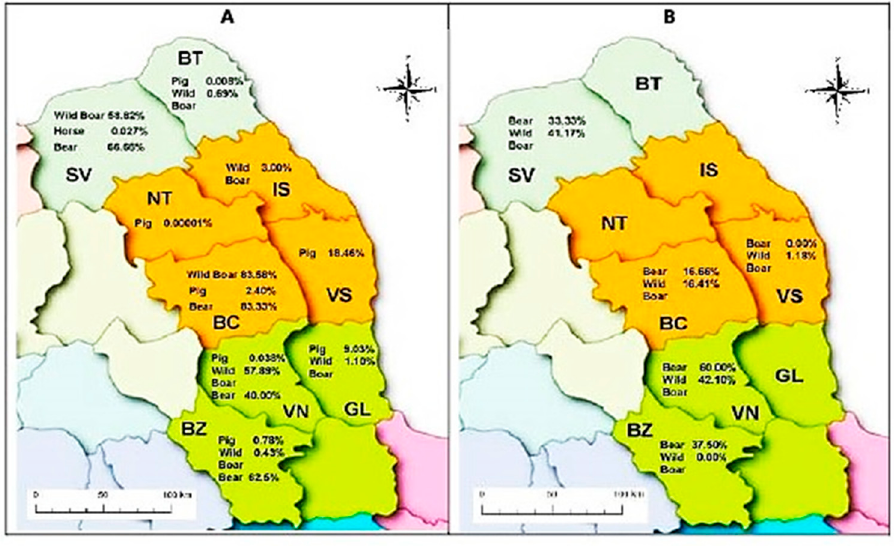
Figure 3. Geographical distribution of positive samples for Trichinella spiralis ( A ) and Trichinella britovi ( B ).